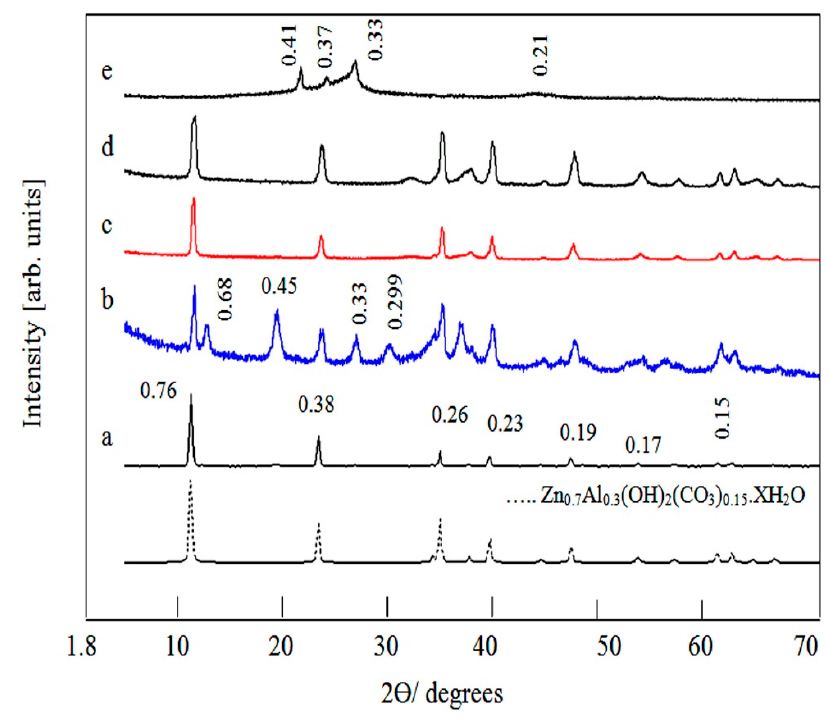
Figure 2. X-ray di ff raction of: ( a ) Zn-Al layered double hydroxide (LDH), ( b ) Zn-Al-GO1, ( c ) Zn-Al-GO2, Figure 2. X-ray diffraction of: ( a ) Zn-Al layered double hydroxide (LDH), ( b ) Zn-Al-GO1, ( c ) ( d ) Zn-Al-GO3 and ( e ) The prepared Zn-Al-GO2, ( d ) Zn-Al-GO3 and ( e ) The prepared graphene.